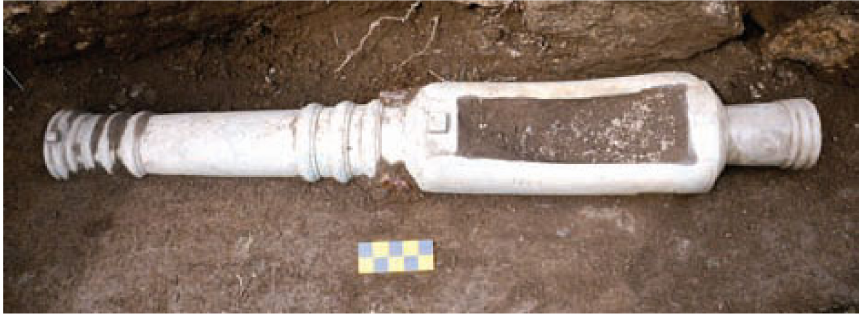
Figure 12. Bulranggi Cloth Used in Dondae. Reprinted with permission from Ref. [50]. 2017, Incheon Metropolitan City